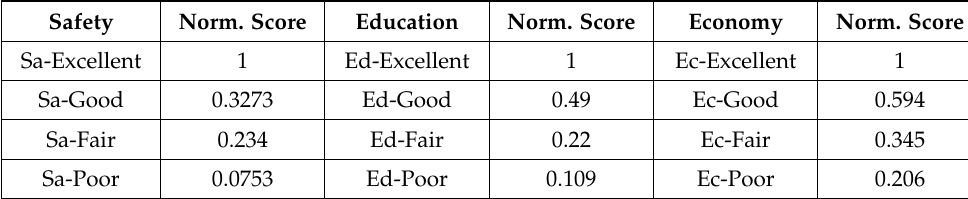
Table 16. Summary Normalized Scores for the 12 intensities.